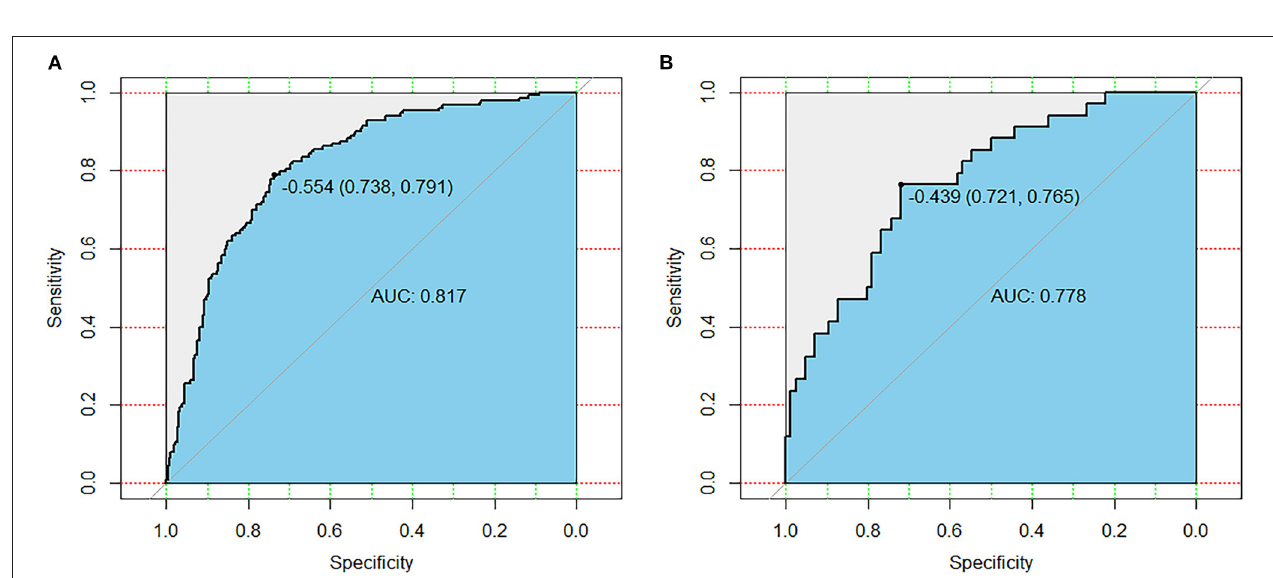
FIGURE 2 | Nomogram for predicting the risk of lower-extremity deep vein thrombosis (DVT). Points were assigned for age, D-dimer level, Glasgow Coma Scale (GCS) score, muscle strength, and infection. The total score obtained by adding up the scores of all individual variables is used to find the appropriate position on the “Risk of DVT” axis to determine the patient’s individual risk of lower extremity DVT. A simple example analysis: A 50-year-old patient ( ∼ 45 points) has a GCS score of 8 (20 points) and muscle strength of 3 grade (22 points) when admitted to the neurointensive care unit. After laboratory tests, his blood D-dimer level was 10 µ g/mL (10 points) after the third day of surgery, and he had no infection (0 points) when he was admitted to the neurointensive care unit. The total score for this patient was 97 points. According to the nomogram, the risk of lower extremity DVT in this patient is ∼ 36%.